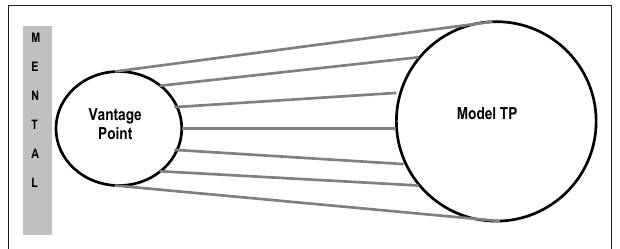
M FIGURE 3: Process (Model TP) within a process (Vantage point).